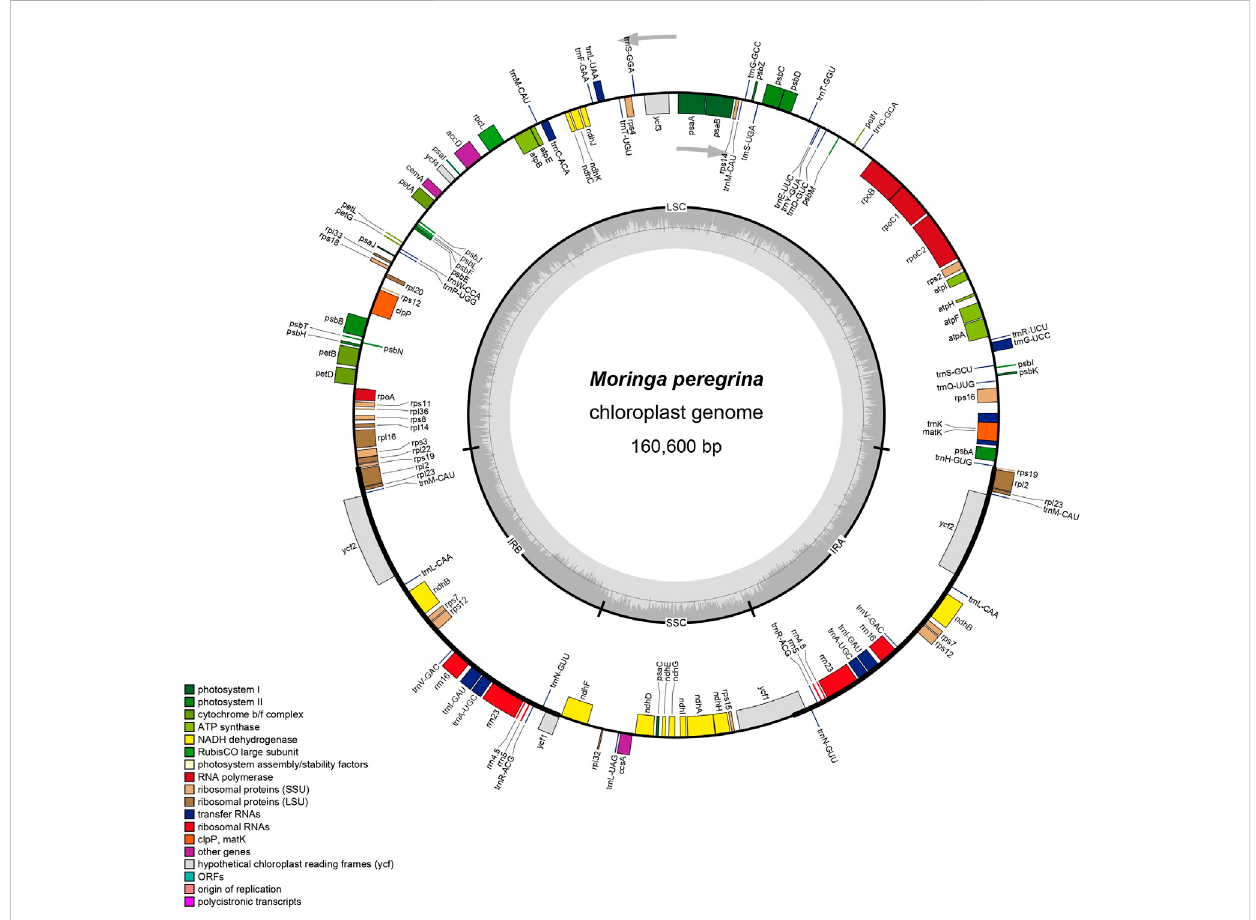
(Table 2). The largest intergenic exon region belongs to the tRNA- UUU gene (2,541 bp), while the smallest exon region is that of trnL- UAA gene (Table 2). When comparing the 26 related plastomes, four common regions include a small single-copy (SSC) part, large single copy (LSC) part, and copy inverted repeat (IR) parts (Table 3). The plastome structure length ranges from 152,860 bp (Brassica napus) to 160,600 bp ( M. oleifera and M. peregrina ). All related plastomes show a typical quadripartite structure, consisting of a couple of IR regions (25,804 – 31,477 bp) divided by the LSC region (83,030 – 88,749 bp) and the SSC region (9.631 – 18,883 bp) (Table 3). Moreover, the total number of genes ranges from 127 to 132, and protein-coding genes range from 73 to 87. In addition, tRNA genes range from 35 to 38, and rRNA genes contain eight genes; and only A. tetracantha has 7 (Table